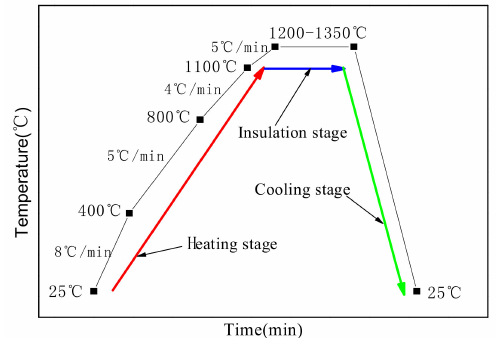
Figure 3. Calcination temperature increase control